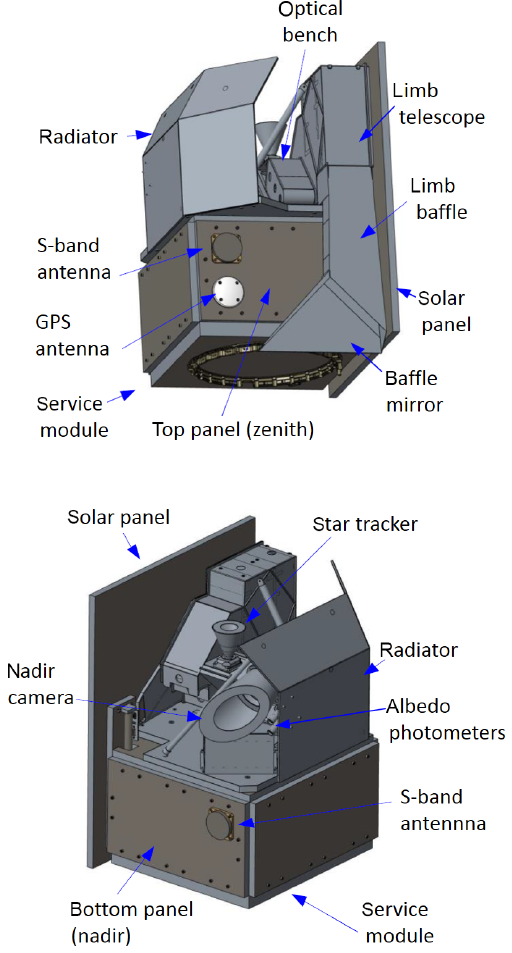
Figure 2. Layout of the MATS satellite.